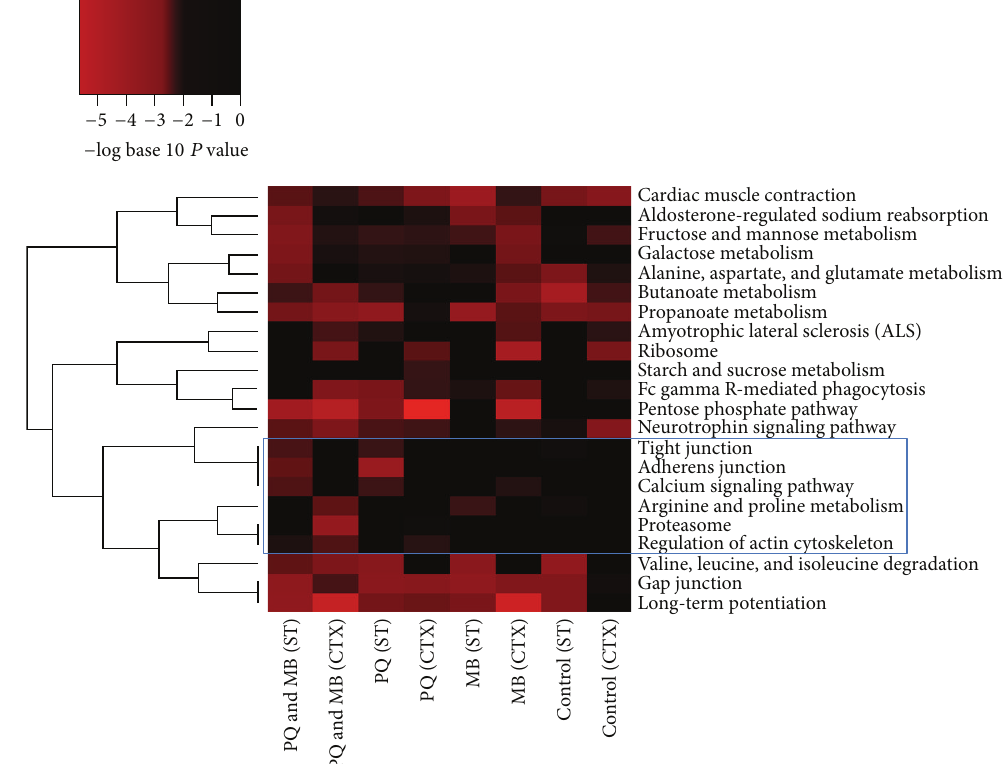
Figure 5: KEGG pathways enriched for carbonylated proteins by pesticide treatment and brain region. The carbonylated proteins identified in two mouse brain regions, striatum (ST) and cortex (CTX), were functionally annotated using DAVID Tools. KEGG pathways were examined for overrepresentation in carbonylated protein lists obtained for each of the four treatment groups, maneb (MB), paraquat (PQ), paraquat and maneb combined (PQMB), and controls, and in each brain region separately. KEGG pathways that were nominally significant ( 𝑃 < 0.01 ) in at least one of the 8 protein lists and not in all 8 protein lists are included in the graphic. The colors of the heatmap range from white ( 𝑃 > 0.01 ) to bright red based on the negative log base 10 transformation of the 𝑃 value. A 𝑃 value of 1 was used when the KEGG pathway was represented by less than two proteins in the list. KEGG pathways (rows) are ordered based on hierarchical clustering where the distance measure was calculated as one minus the Spearman correlation coefficient when 𝑃 values were converted to a binary indicator of significance ( 𝑃 < 0.01 versus 𝑃 ≥ 0.01